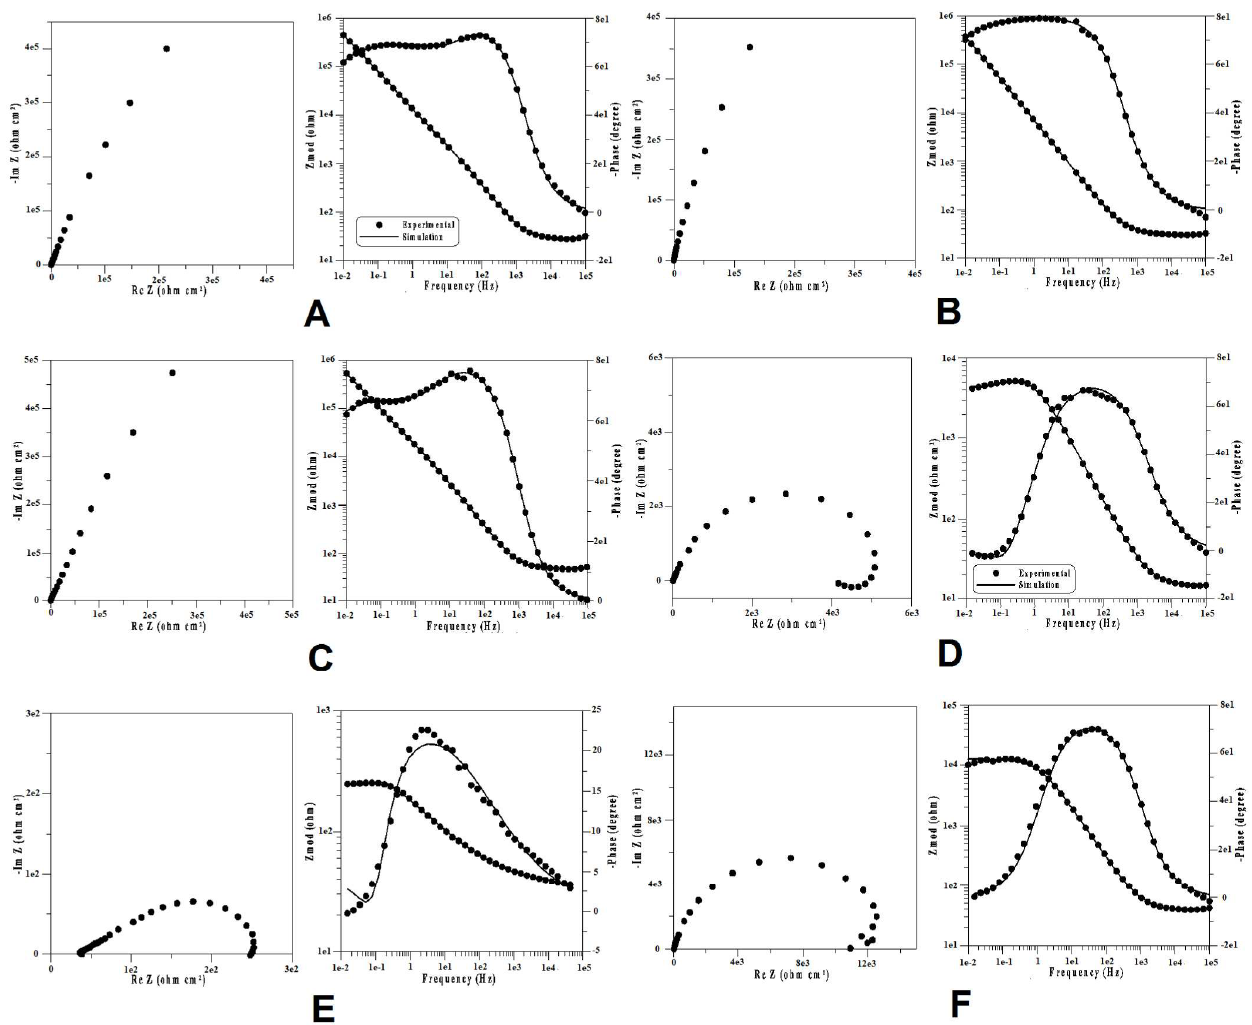
Figure 6. Bode spectra and Nyquist plot diagrams for NiCr-based dental alloys in Ringer solution at a potential of 100 mV/ESC. ( A ) Specimen Ni1. ( B ) Specimen Ni2. ( C ) Specimen Ni3. ( D ) Specimen Ni4. ( E ) Specimen Ni6. ( F ) Speci- men